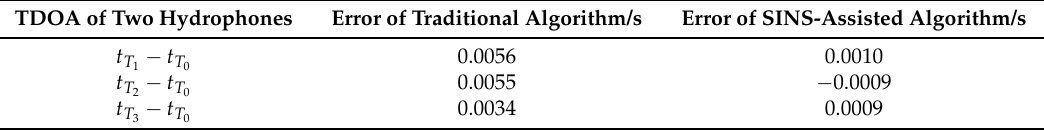
Table 1. Comparison of TDOA (Time Difference of Arrival) calculation error.